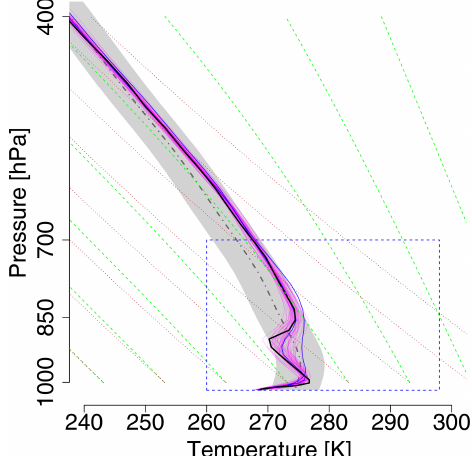
Figure 6. Vertical temperature profiles as observed (black bold solid line) and the members (magenta) of the + 30h raw ensemble forecast at station Bergen for 6 December 2016, 06:00Z. Two mem- bers are highlighted with blue. The rectangle with a blue dashed border indicates the zoomed pressure and temperature range plotted in Fig. 7. Gray-thick-dashed-dotted area is the climatological mean of the EPS for this specific date and time and the gray shaded area indicates its ± 1 standard deviation range. Green dashed lines are the saturated adiabats, dotted lines the dry adiabats.